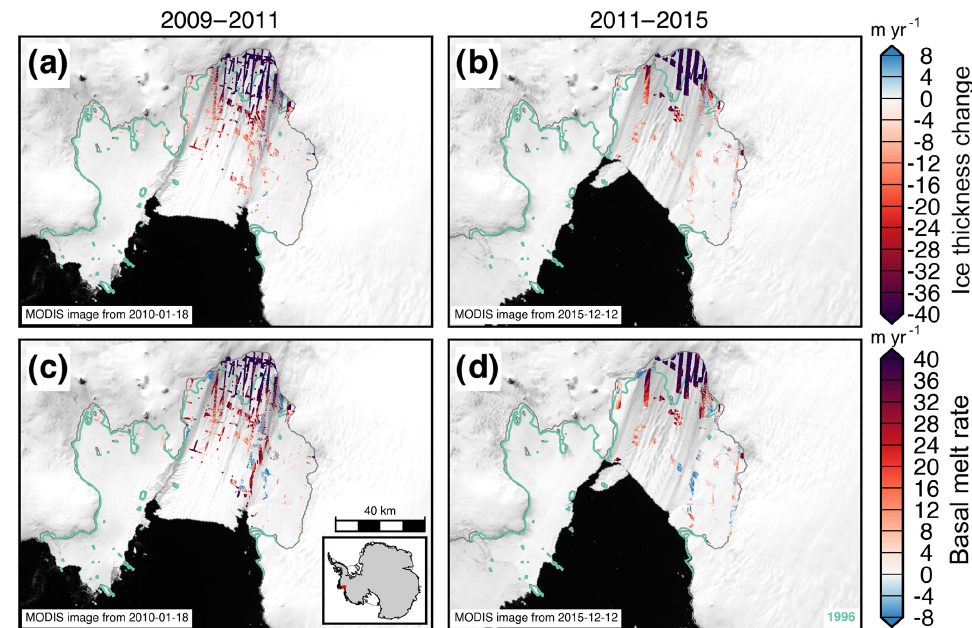
Figure 9. Ice thickness change (a–b) and estimated basal melt rates (c–d) of the Pine Island Ice Shelf for two periods, 2009–2011 and 2011– 2015. MEaSUREs InSAR-derived Antarctic grounded ice boundaries are denoted in gray (Mouginot et al., 2017b). The 1996 InSAR-derived grounding line locations from Rignot et al. (2016) are delineated in green. Plots are overlaid on MODIS images of Antarctic ice shelves provided by NSIDC (Scambos et al., 2001). The inset map denotes the location of the maps.